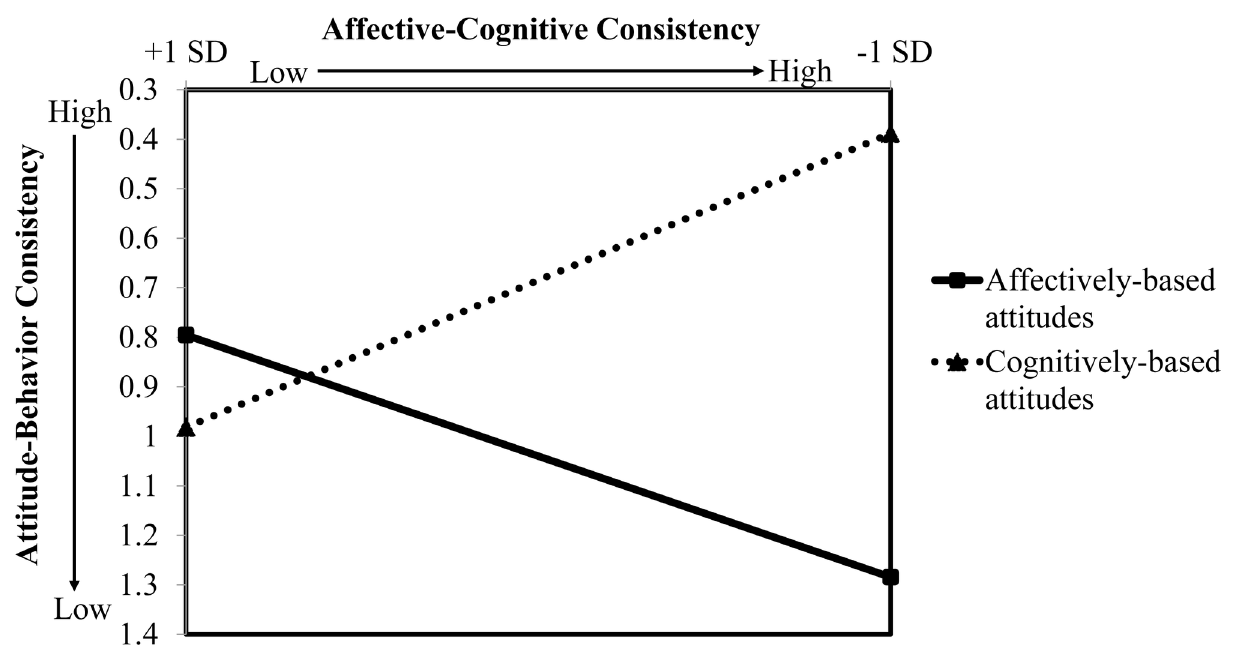
Figure 2. Effects of attitude base and affective-cognitive consistency on intergroup instrumental behaviors in Study 2. This figure was plotted by using the unstandardized regression weights with affective-cognitive consistency along the abscissa at + 1 SD from the mean. Lower affective-cognitive consistency scores signified higher affective-cognitive consistency of group attitudes. Similarly, lower attitude-behavior consistency scores indicated a stronger relation between attitudes and behaviors. Results representing the moderating role of affective-cognitive consistency in the effects of affectively-based and cognitively-based attitudes on intergroup instrumental behaviors show that cognitively-based attitudes predicted intergroup instrumental behaviors more strongly than affectively-based attitudes only when affective-cognitive consistency was